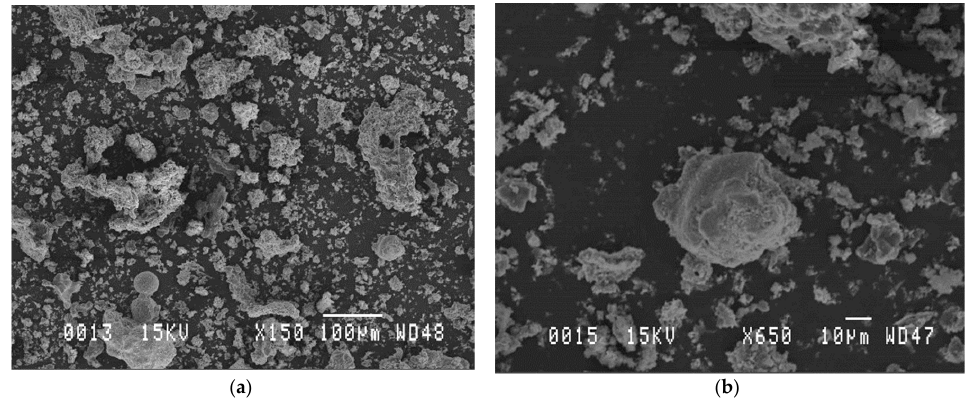
Figure 2. Low magnification ( a ) and high magnification ( b ) scanning electron microscopy of wood ash (WA).